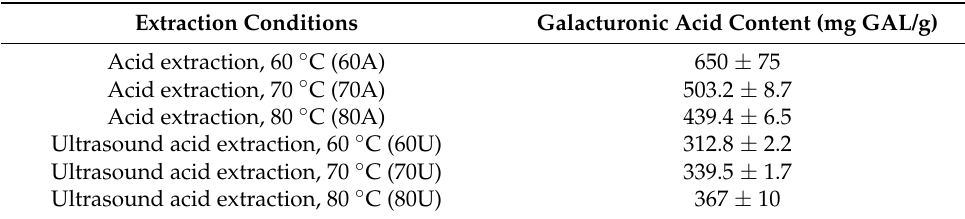
Table 4. The content of galacturonic acid in the samples of kaffir lime pectins depending on the extraction conditions used in terms of dry